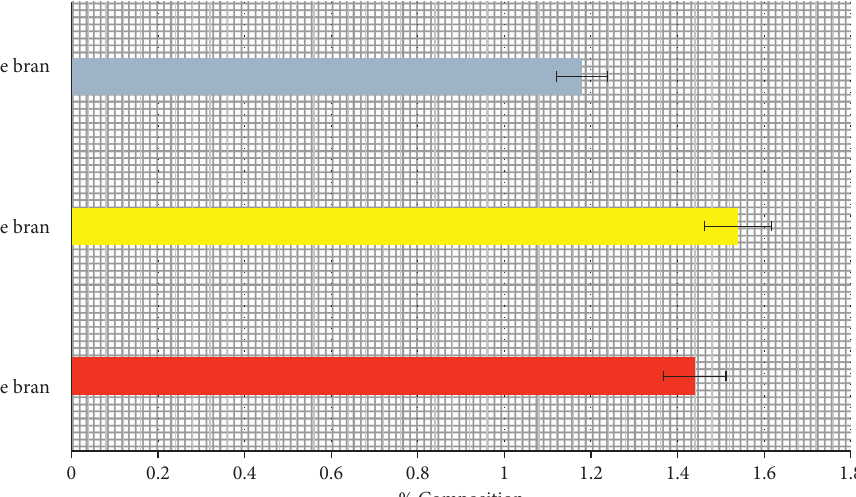
Figure 2: Percentage moisture content of poultry-mix.